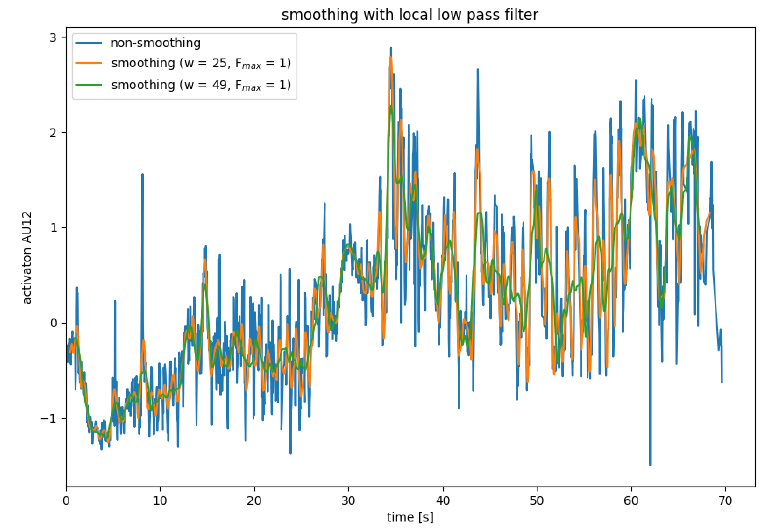
Figure 7. AU smoothing with average mean with a local low pass